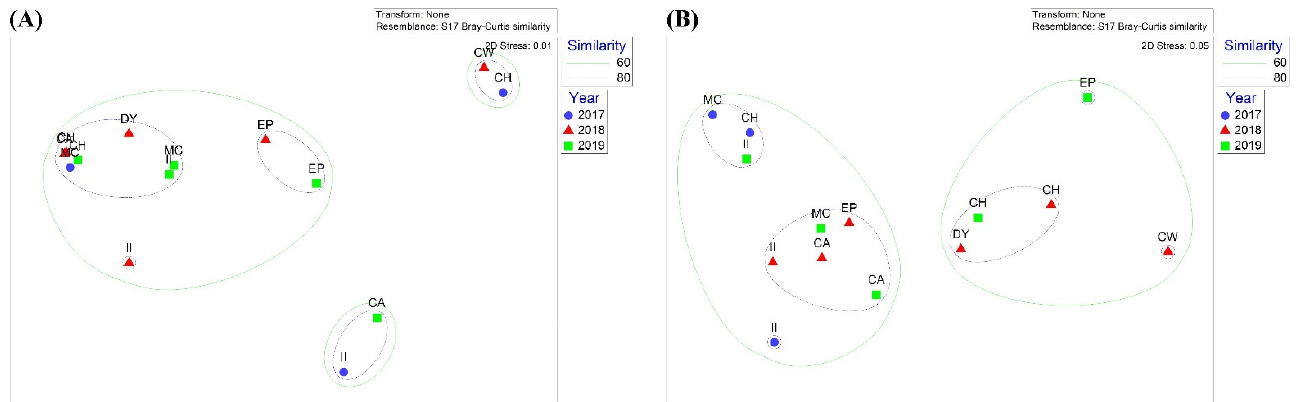
Figure 3. Nonmetric multidimensional scaling (NMDS) plot of ( A ) eukaryotic communities using 18Sv9 metabarcoding and ( B ) fish communities using miniFish metabarcoding in different years. Solid lines indicate 60% and 80% similarity.